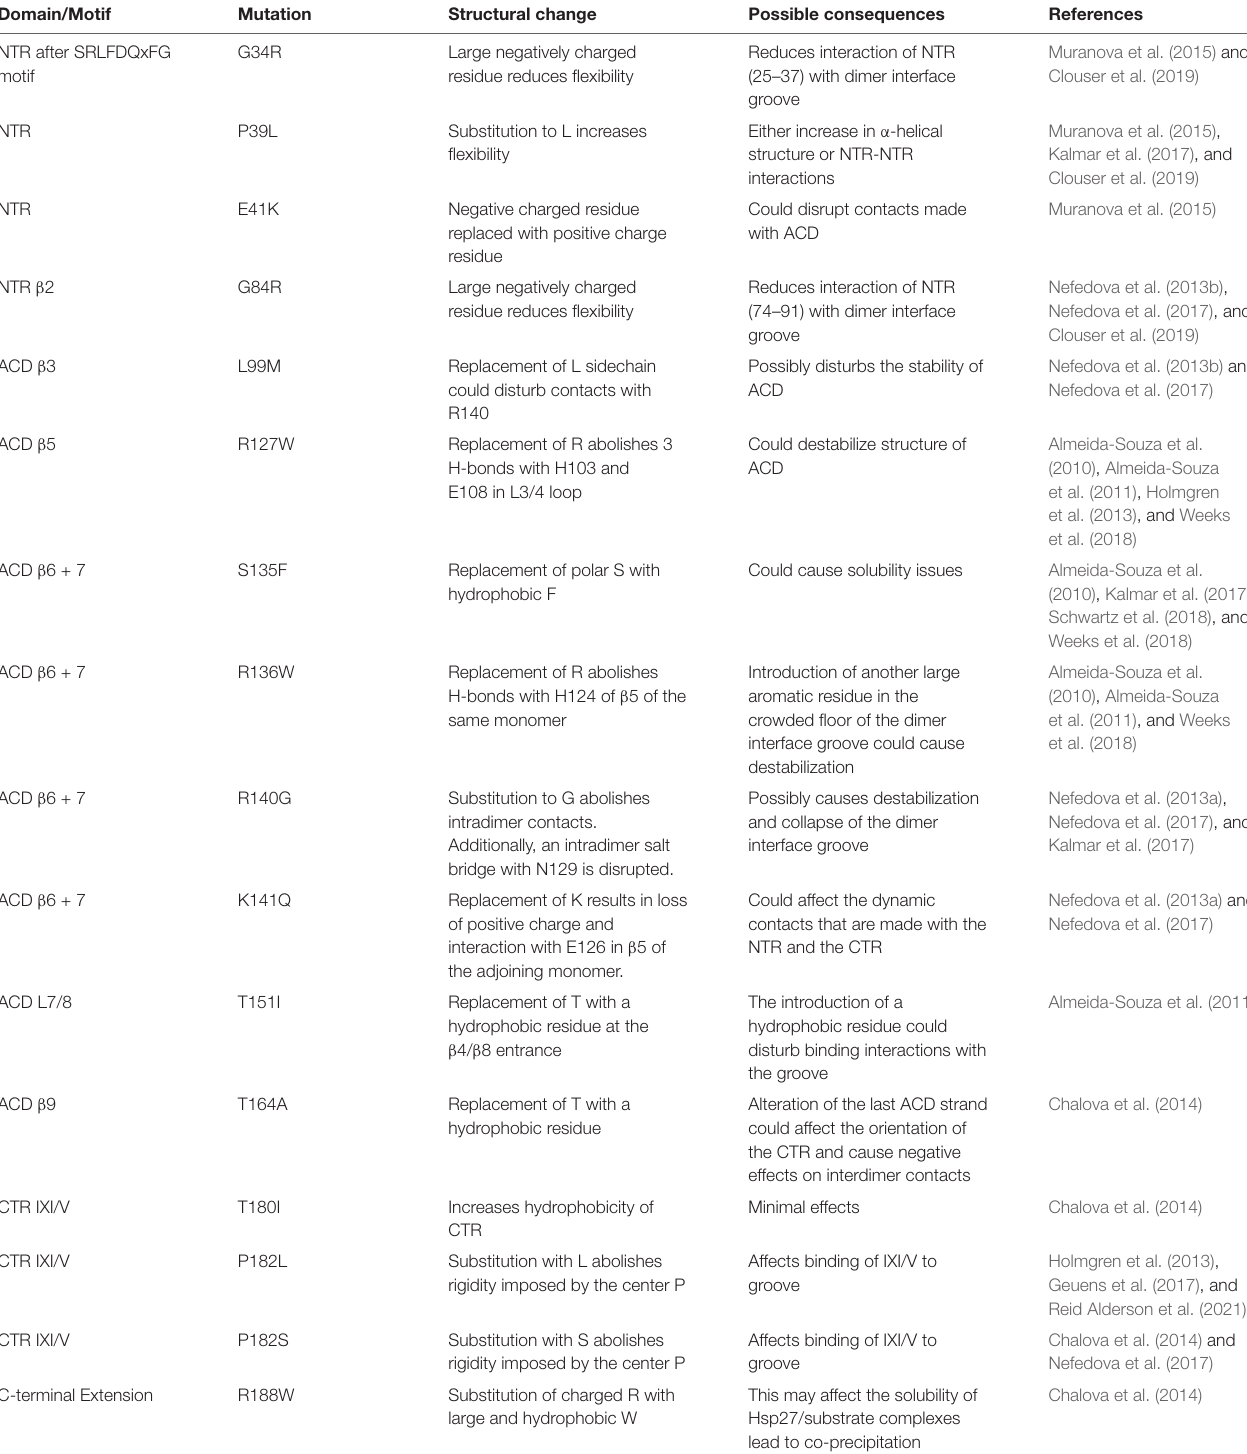
TABLE 1 | Hsp27 mutations associated with CMT2F and